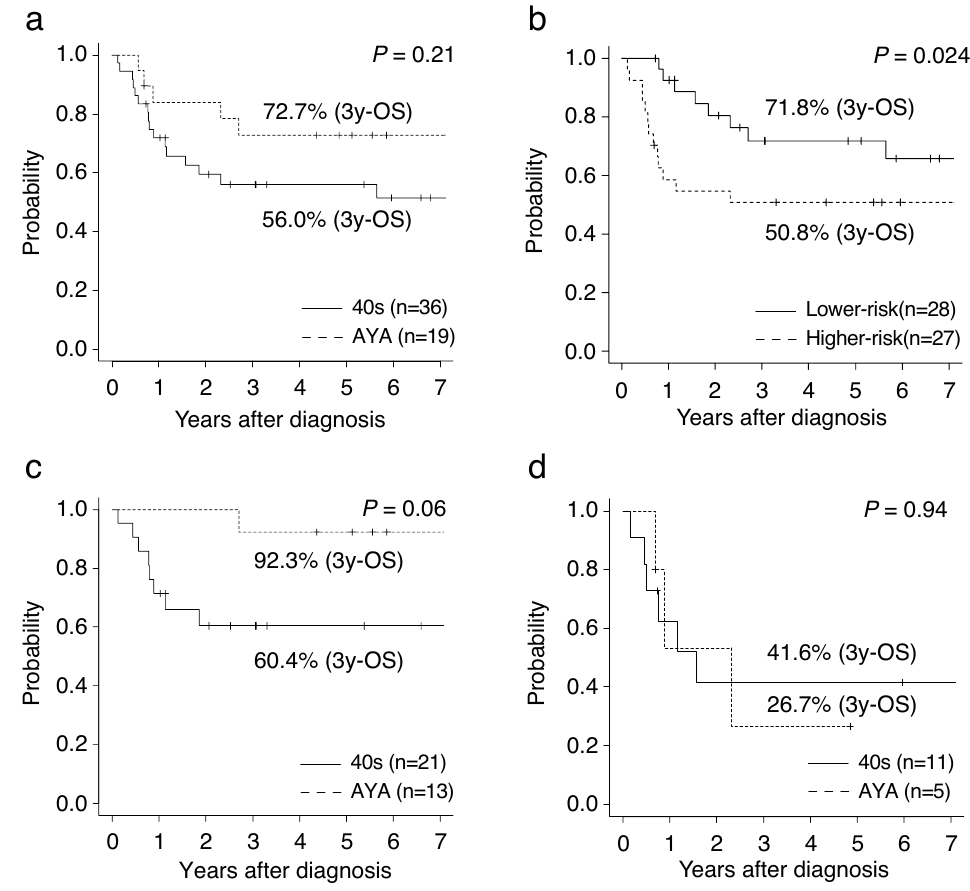
Figure 2. Survival outcomes of 55 patients. Overall survival (OS) compared between the AYA generation and patients in their 40s ( a ), higher-risk and lower-risk patients (higher-risk was defined as patients with two or more gene mutations and/or any copy number alterations) ( b ). OS stratified by generation in IPSS low- or intermediate-1 risk ( c ) in IPSS intermediate-2 or high risk ( d ). AYA, adolescent and young adult; CK, complex